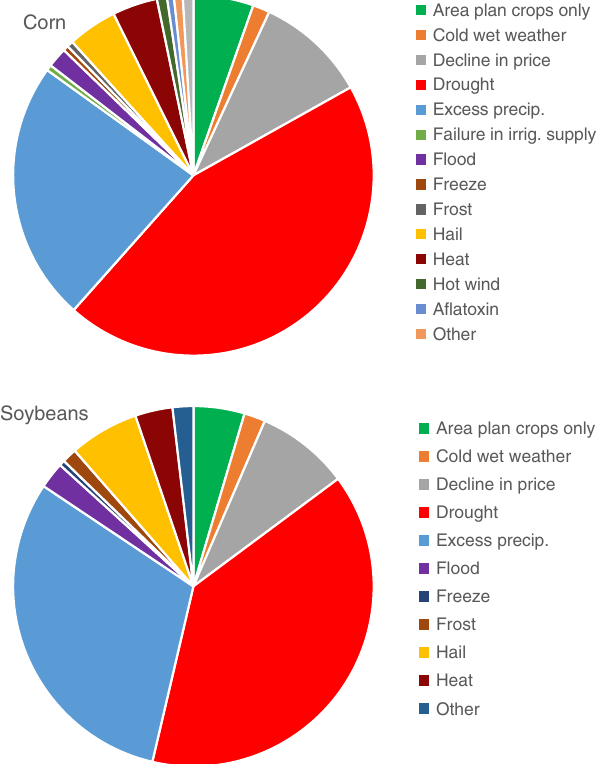
Fig. 1 Indemnity payment shares by cause of loss, 1989 – 2014. Each portion of the pie chart represents the average share of indemnity payments in each crop due to a particular